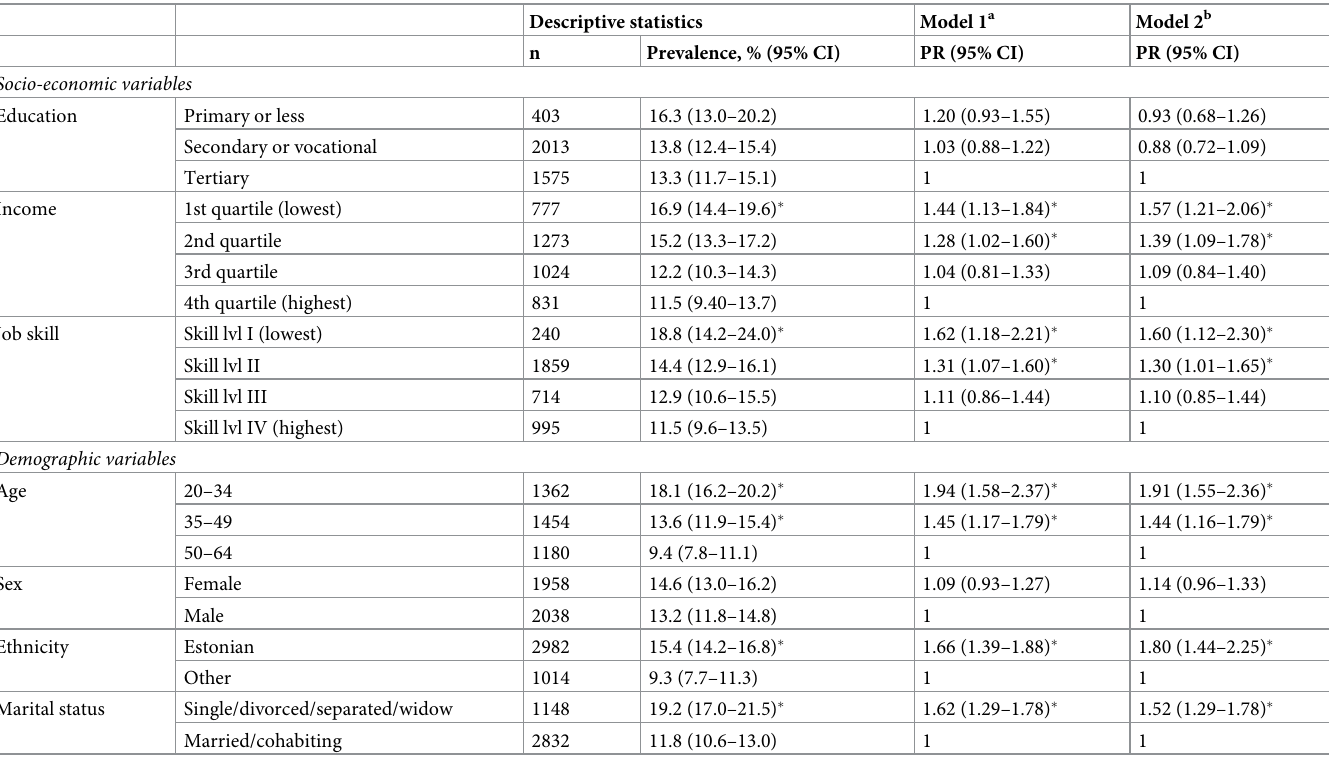
Table 4. Suicidal thoughts and association with socio-economic and demographic variables, descriptive statistics and prevalence ratios with 95%